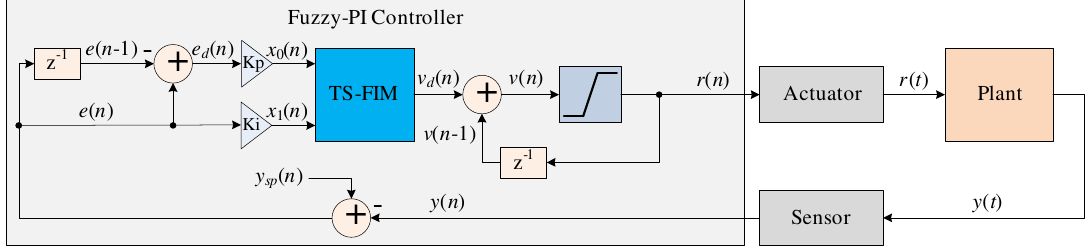
Figure 1. Architecture of the Fuzzy-PI feedback control system operating a generic